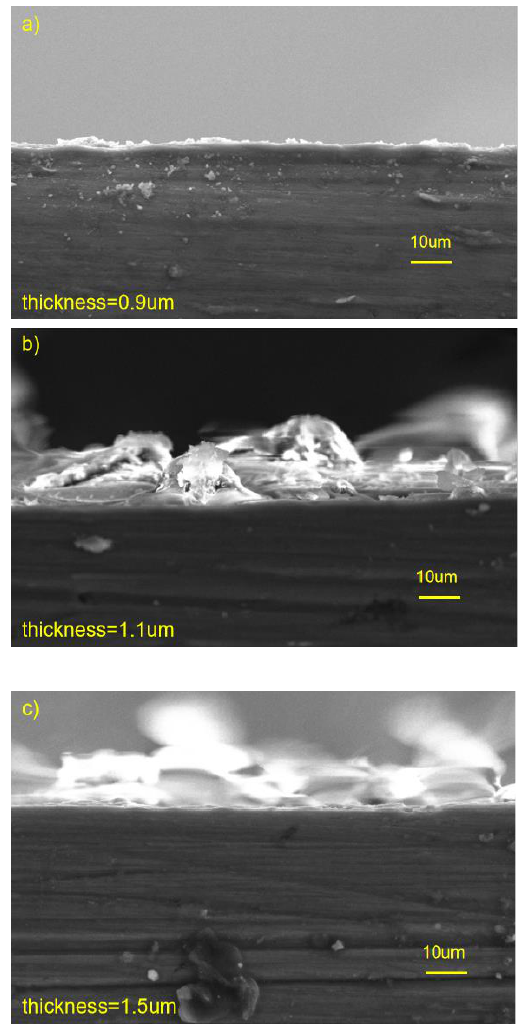
Figure 5. SEM micrograph of the cross-section of three coated samples ( a ) HF- Mg, ( b ) PLLA (5)-HF- Mg, ( c ) PLLA